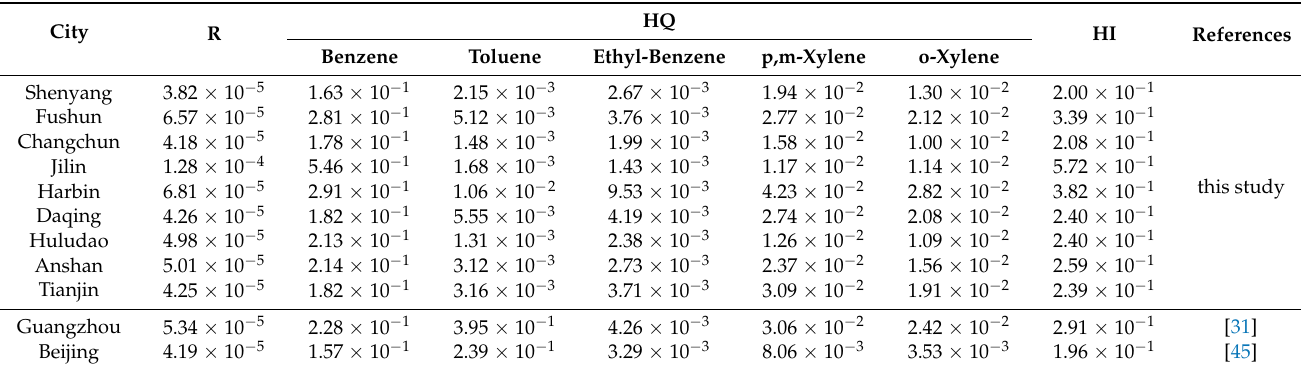
Table 4. Comparison of non-carcinogenic and carcinogenic risks of benzene series in nine cities of NRC with other